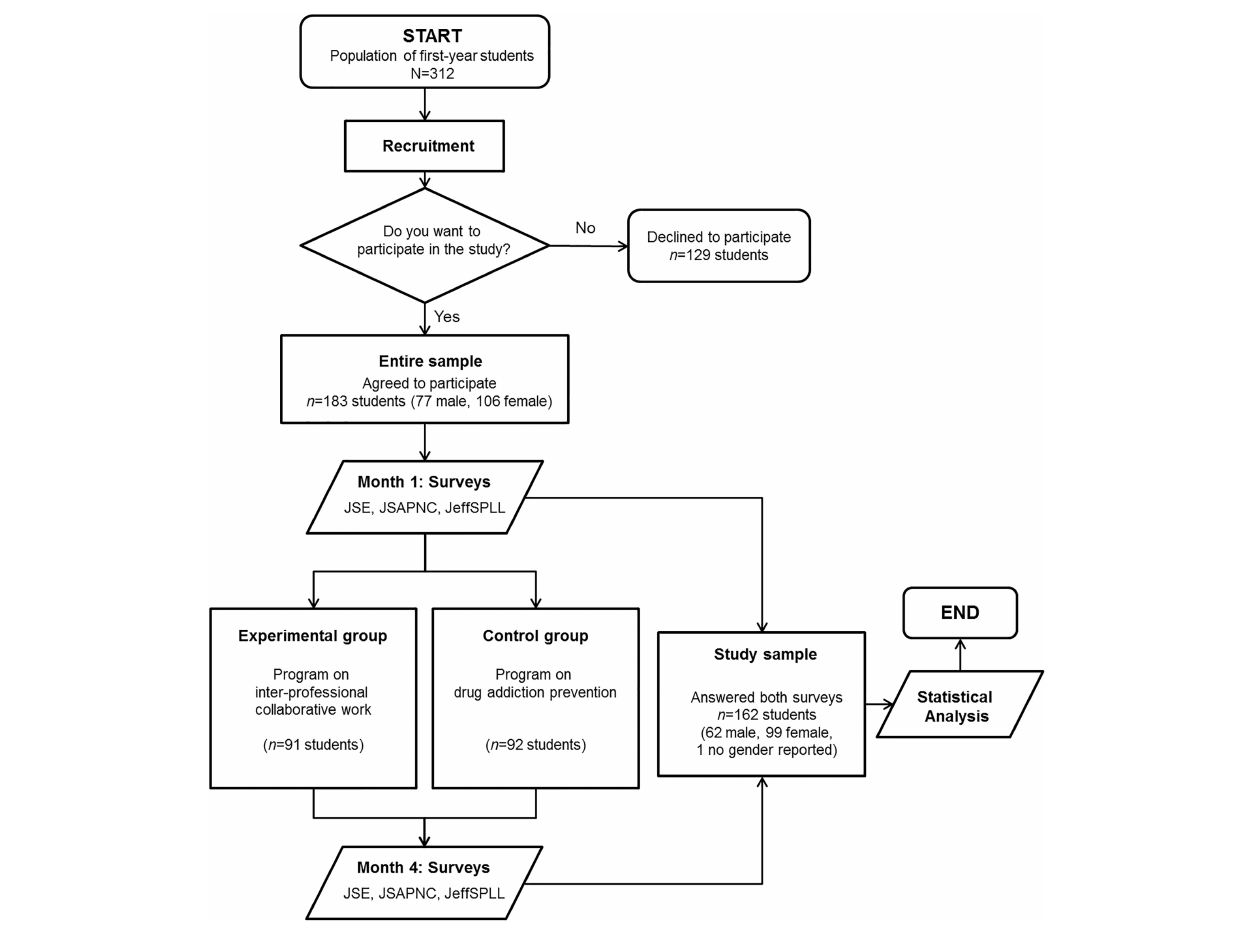
FIGURE 1 | Schematic overview of the workflow diagram followed in this study. JSAPNC, Jefferson Scale of Attitudes toward Physician-Nurse Collaboration; JSE, Jefferson Scale of Empathy (JSE-S, Medical Student version and JSE-HPS, Health Professions Student version); JeffSPLL, Jefferson Scale of Lifelong Learning (JeffSPLL-MS, Medical Student version and JeffSPLL-HPS, Health Professions Student version).